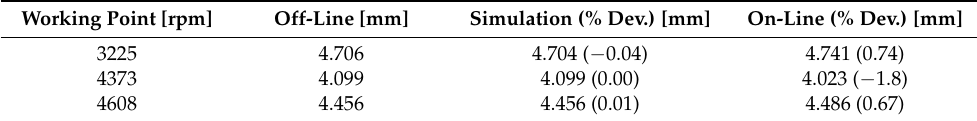
Table 1. Minimum TC [mm] obtained with the one-turn-original set of signals.